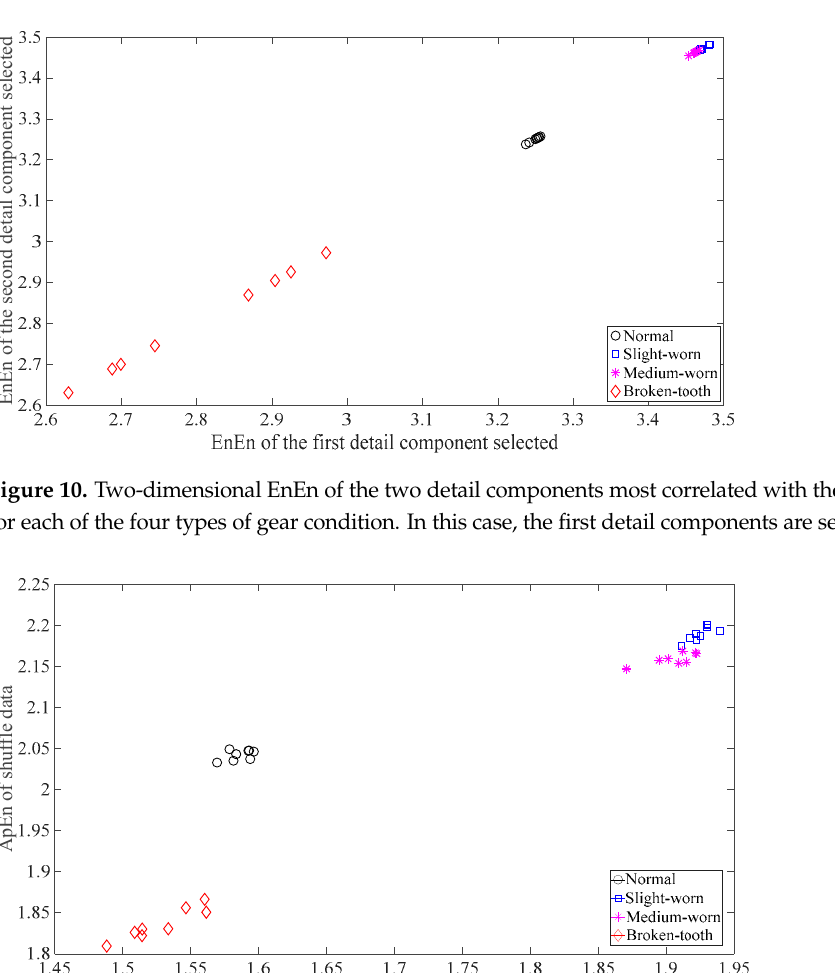
Figure 11. Binary ApEn of the original and shuffle versions of the four types of gear vibration data.